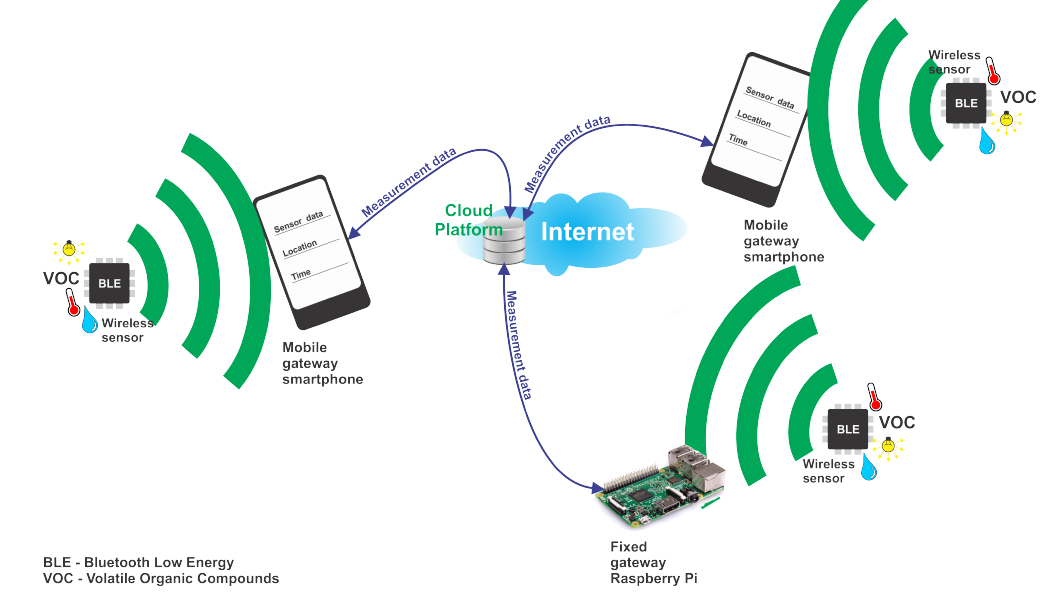
Figure 1. Air pollution monitoring system architecture.